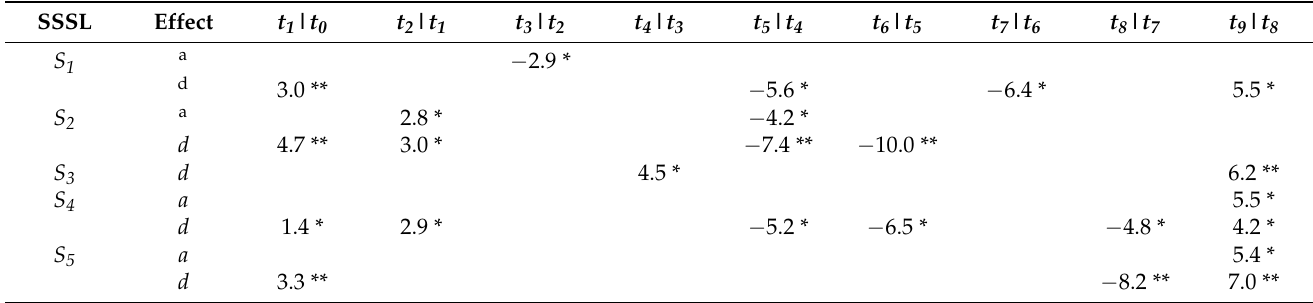
Table 4. Expression of QTLs according to additive and dominant effects on the leaf numbers in various developmental stages. SSSL is an abbreviation of single-segment substitution line. S i represents the i th SSSL. aa , ad , da , and dd represent additive-additive, additive-dominant, dominant-additive, and dominant-dominant epistases, respectively. t i | t i − 1 indicates the stage from i − 1 to t . “ − ” indicates descending leaf numbers due to alleles from the donors. * and ** show significance at the levels of the 0.05 and 0.01 probabilities, respectively.